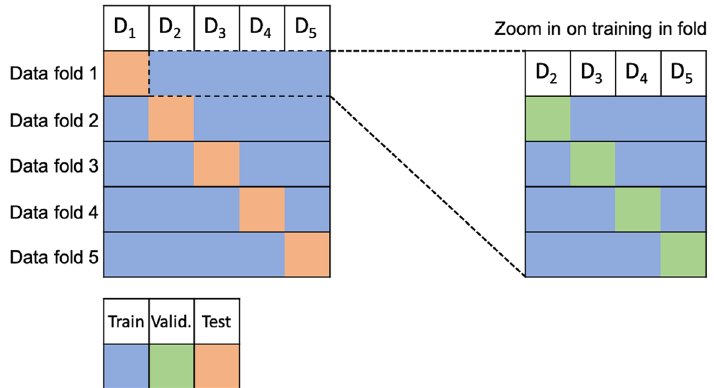
Fig. 4 The extensive cross-validation scheme. Figure adapted from Henckaerts et al.